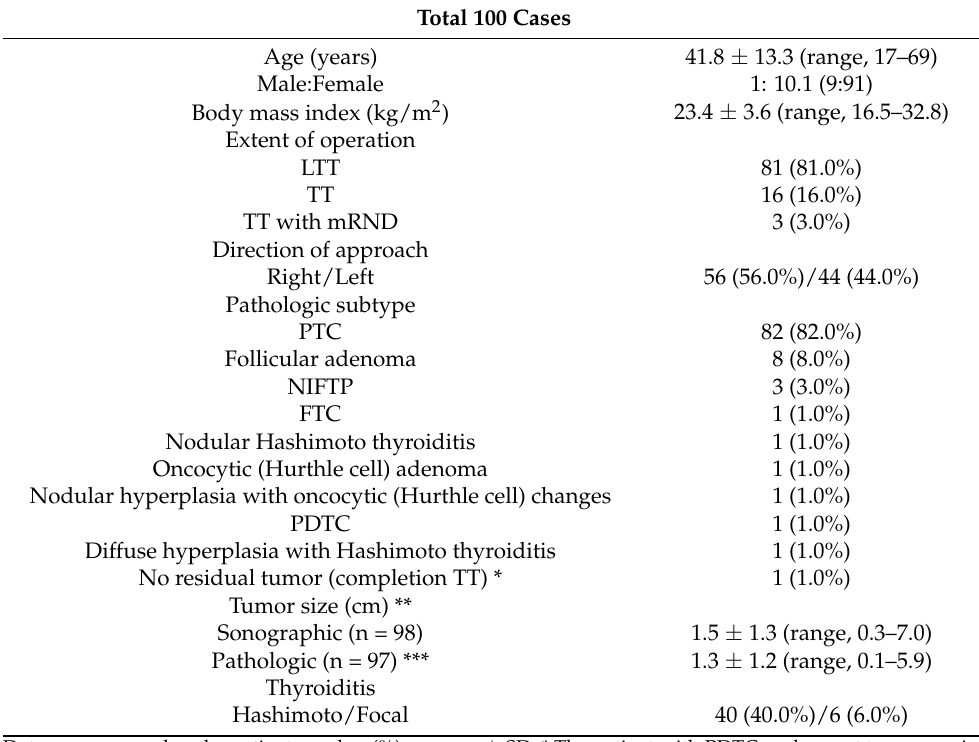
Table 1. Baseline clinicopathological characteristics of the study